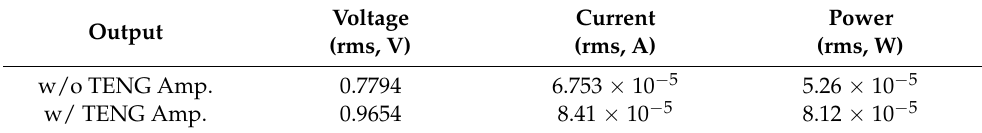
Table 1. Comparison of rms values of TENG output performance with and without the amplifier. Voltage Output (rms,